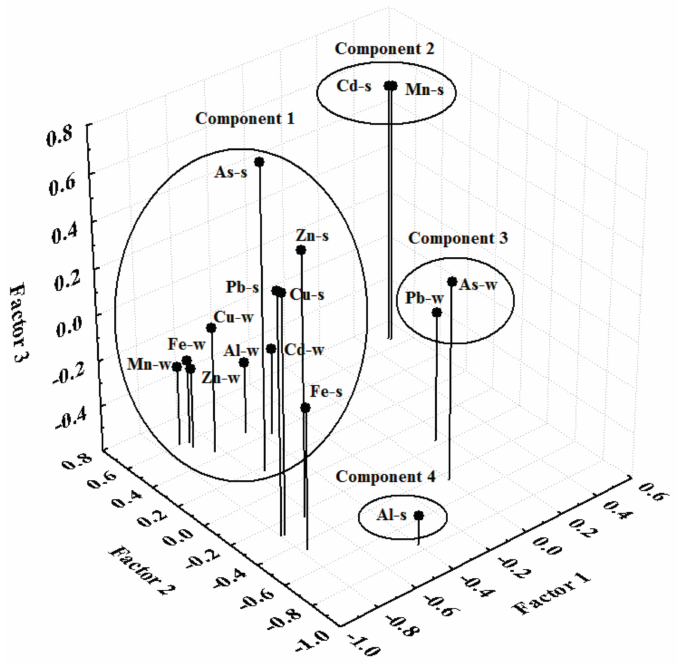
Figure 7. Graphical display of the principal components influencing the heavy metal concentration in sediment and water between sediment sites 4 and